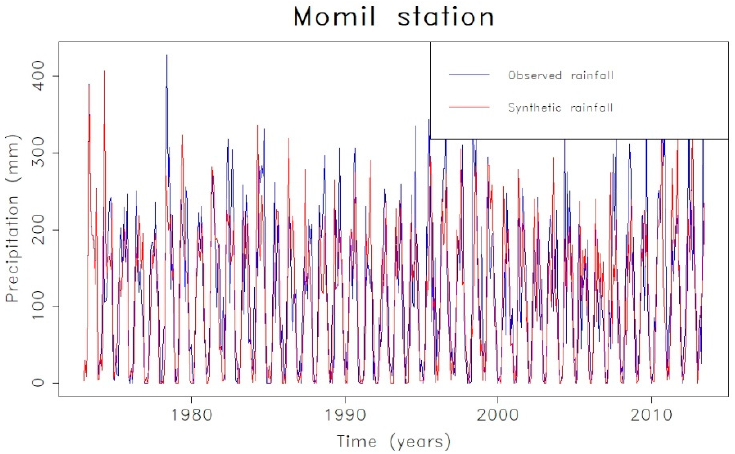
Figure 8. Observed precipitation (calibration vector) and synthetic time